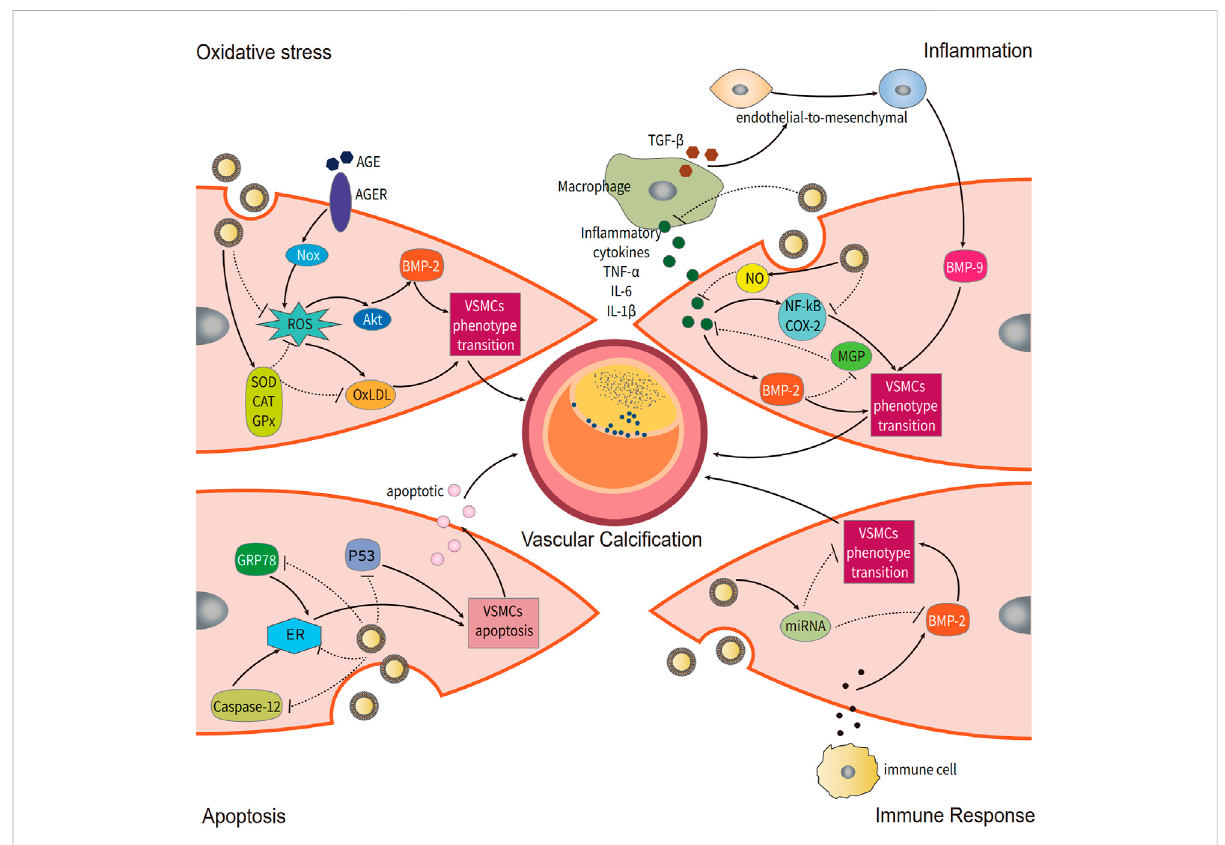
FIGURE 2 Potential regulatory mechanisms of grape exosome-like nanoparticles (GENs) for vascular calci fi cation (VC). Several mechanisms of VC occurrence are modulated by GENs, including oxidative stress, in fl ammation, apoptosis, and immune response.